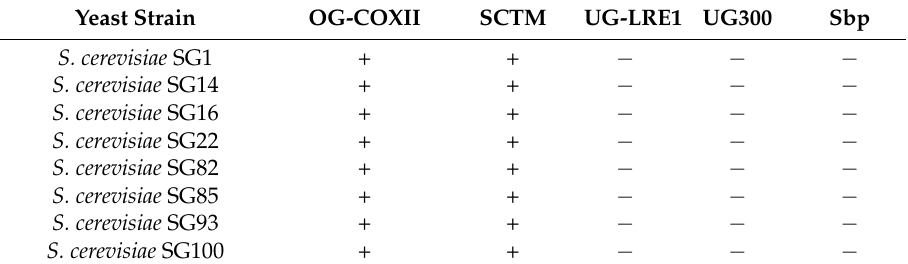
Table 3. Results of the real-time PCR differentiation between top- (OG-COXII and SCTM) and bottom-fermenting (UG-LRE1; UG300 and Sbp) yeasts (+ = positive PCR reaction; − = negative PCR reaction).